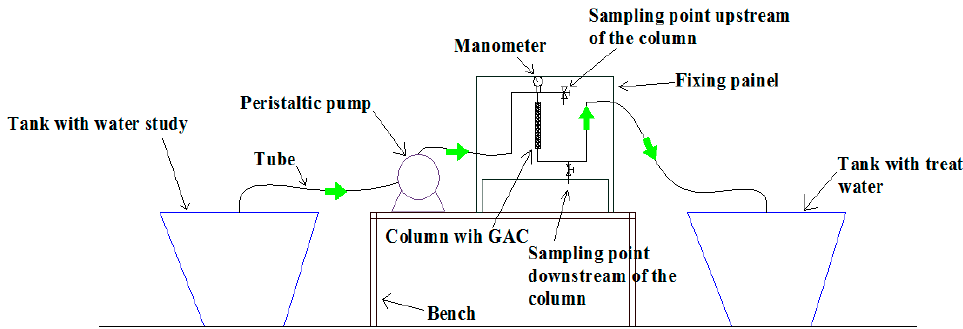
Figure 3. Experimental system used in SBA test.